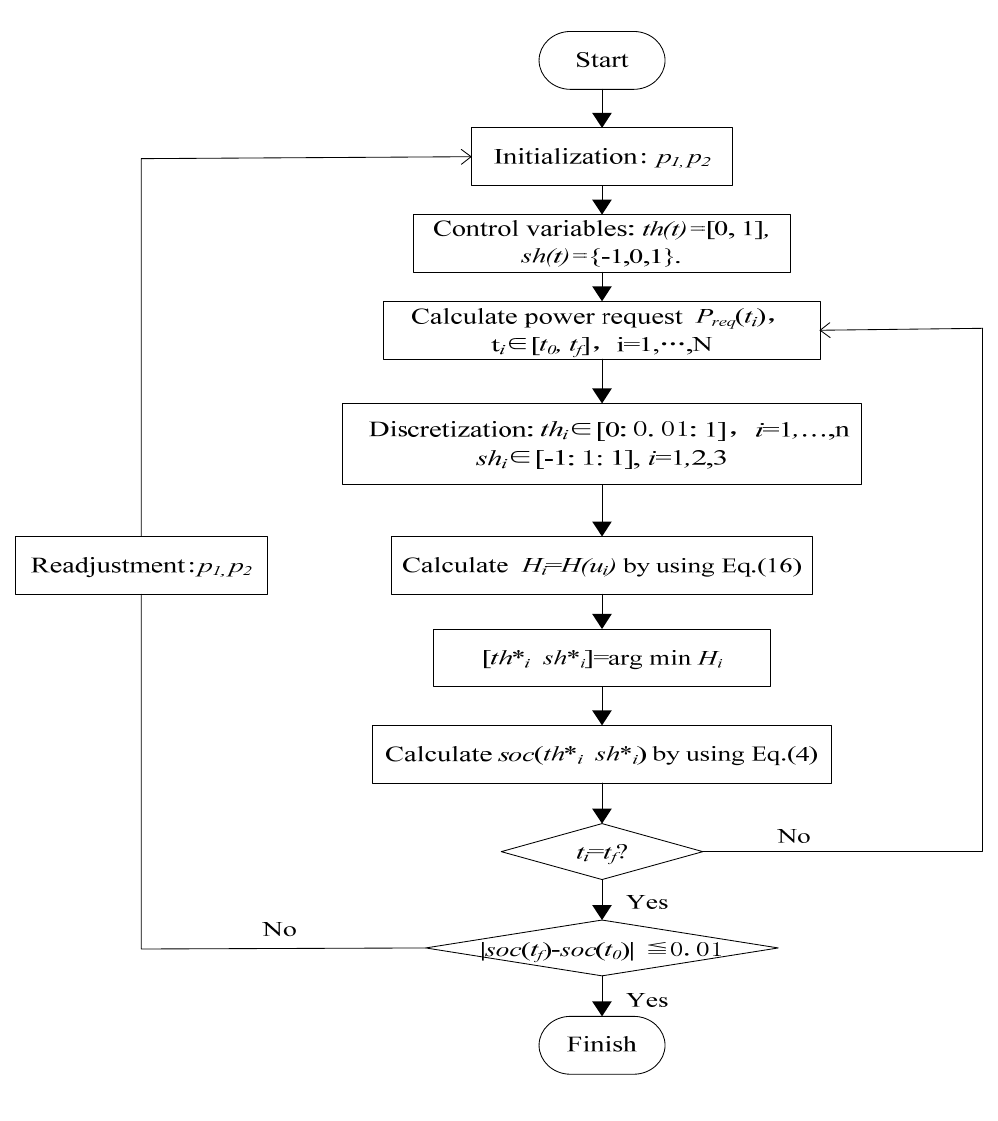
Figure 4. The iterative procedure of